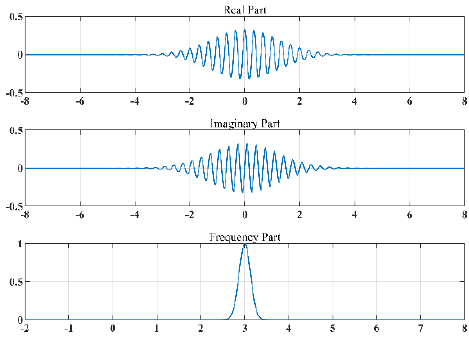
Figure 7. Complex Morlet wavelet with f b = f c = 3.